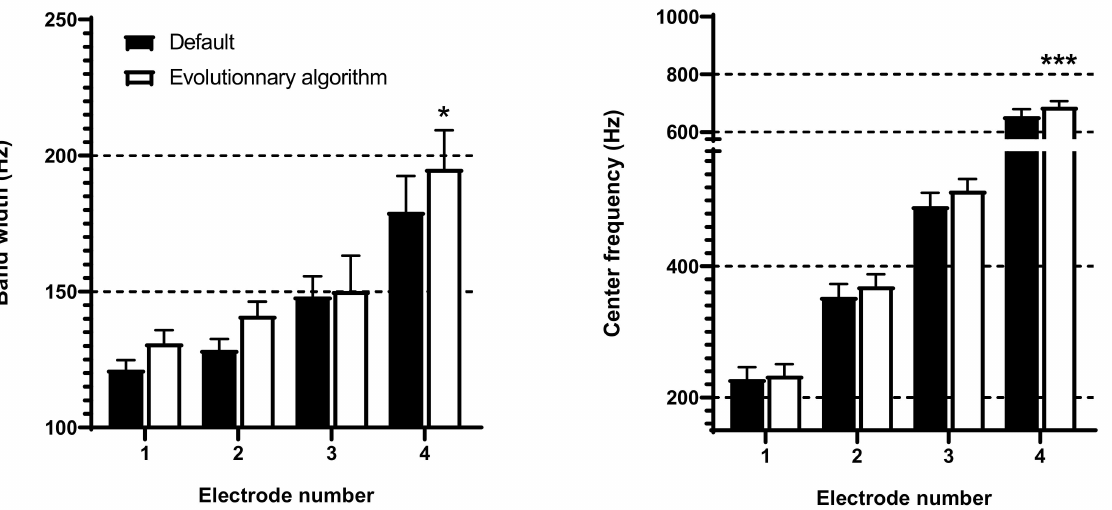
Figure 4. Effect of evolutionary algorithm (EA) after mutations and evolutions on frequency band- width, and center frequencies for the 4 most apical electrodes (electrode 1 representing the most apical as in MED-EL and Advanced Bionics CIs). Values are expressed as mean ± standard error of mean ( n = 27). * p < 0.05 for the effect of EA on band width, and *** p < 0.001 for the effect of EA on center frequencies; in both analyses, p < 0.001 for the effect of electrode number and no significant interaction, two-way